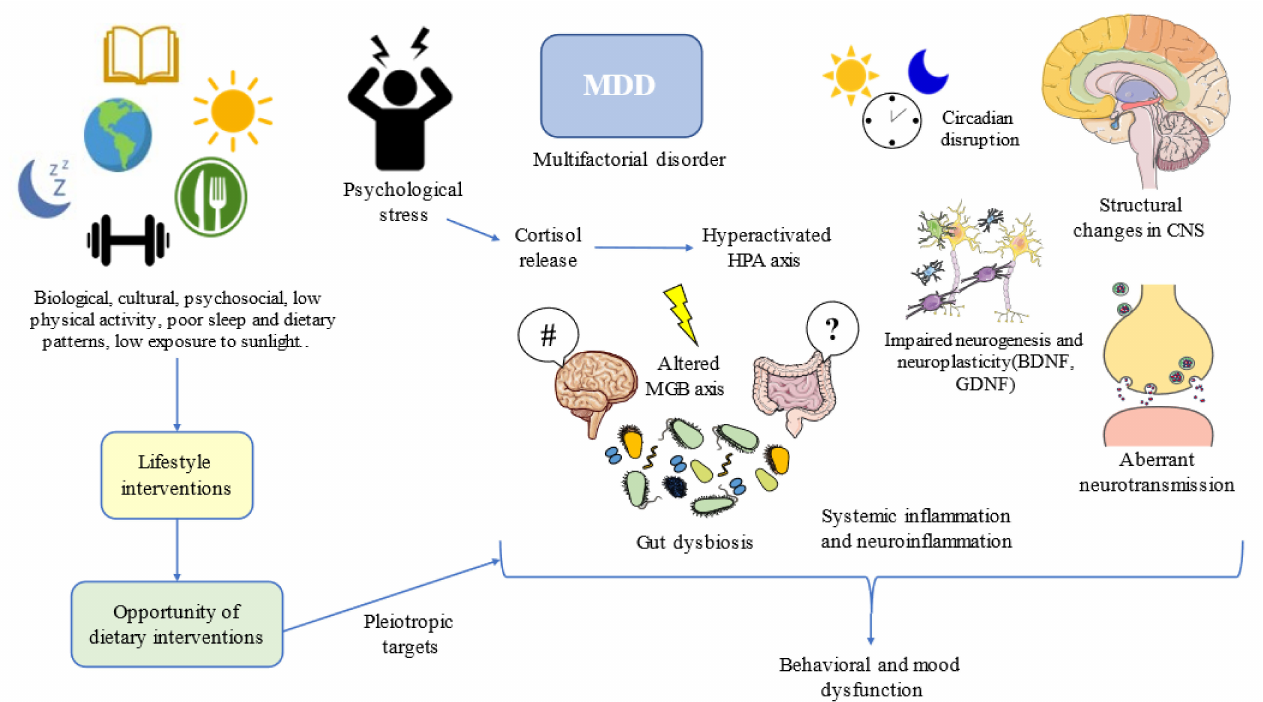
Figure 1. Lifestyle interventions such as dietary interventions suppose an opportunity for addressing multiple targets in the complex network of depression. MDD: Major Depressive Disorder; HPA: hypothalamic–pituitary–adrenal; CNS: central nervous system; MGB: microbiota–gut–brain; BDNF: brain-derived neurotrophic factor; GDNF: glial-derived neurotrophic factor. #/?: Aberrant gut brain crosstalk due to an impaired MGB